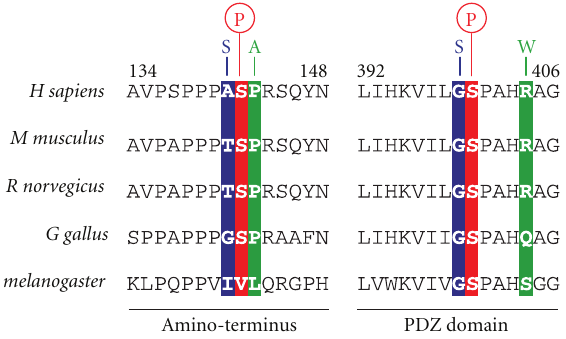
Figure 1: Mutations in HTRA2 associated with Parkinson’s disease lie in close proximity to p38 and CDK5 phosphorylation sites. Mutations in the amino-terminus (A141S [6] and P143A [18]) and the PDZ domain (G399S [6] and R404W [19]) are indicated. The relative positions of the phosphorylation sites in human HTRA2 (see [20, 21]) are indicated by the circles above the serine residues. A sequence alignment with HTRA2 orthologues from several species is